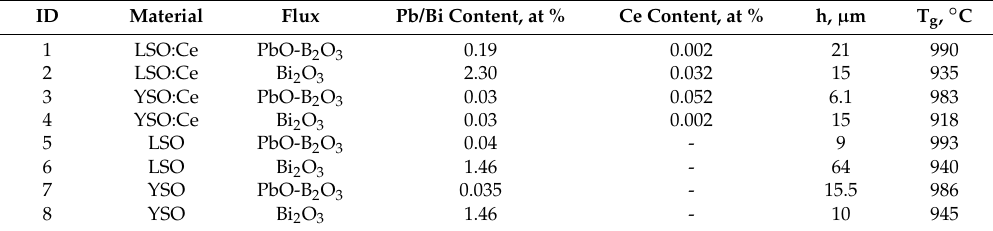
Table 1. Growth conditions of the Lu 2 SiO 5 (LSO)- and Y 2 SiO 5 (YSO)-based single crystalline film (SCF) samples under study. T g and h are the temperature and the thickness of SCF growth.